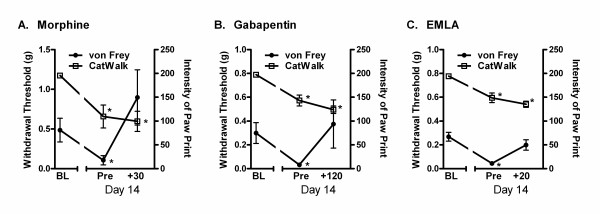
Pharmacological dissociation between mechanical allodynia and dynamic weight bearing (gait) changes following SNI injury in CD-1 mice. Symbols in A-C represent mean ± S.E.M. von Frey withdrawal thresholds (g; solid symbols) and CatWalk ipsilateral hind paw print intensity (0-250; open symbols) prior to SNI (baseline; BL) and on post-operative day 14, both prior to (Pre) and subsequent to (time post-injection in min is listed) administration of 10 mg/kg morphine (A), 75 mg/kg gabapentin (B), or topical EMLA (C). *p < 0.05 compared to same-test BL.